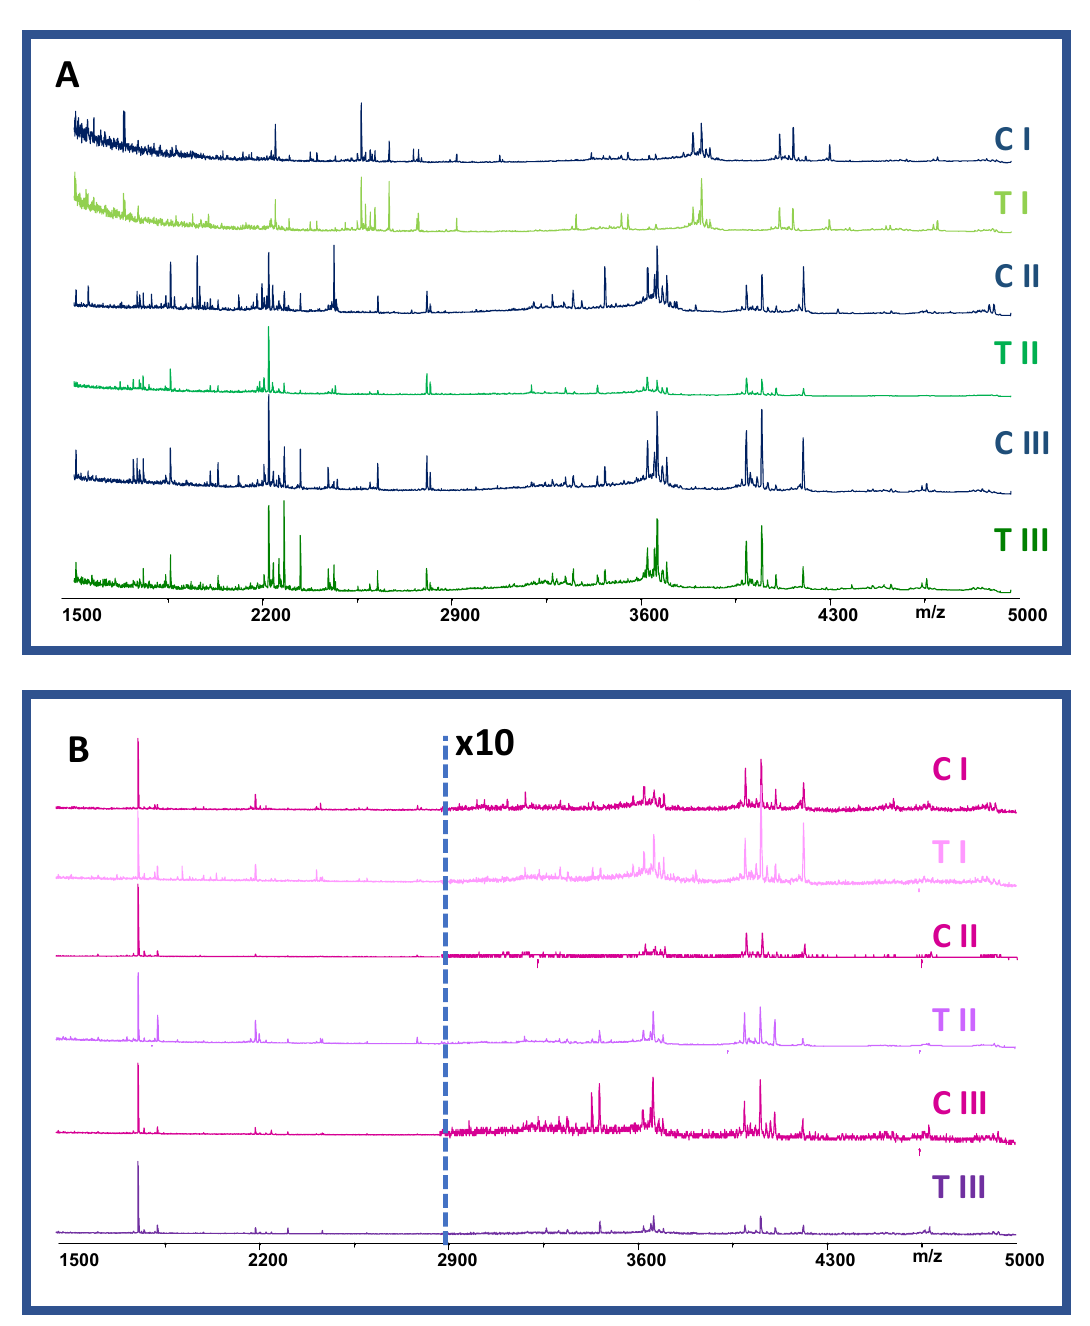
Figure 3. Untargeted molecular profiles of control (C) and treated (T) male insects (panel ( A )) and female insects (panel ( B )), after 2 (I), 7 (II), and 21 (III) days of PND treatment.